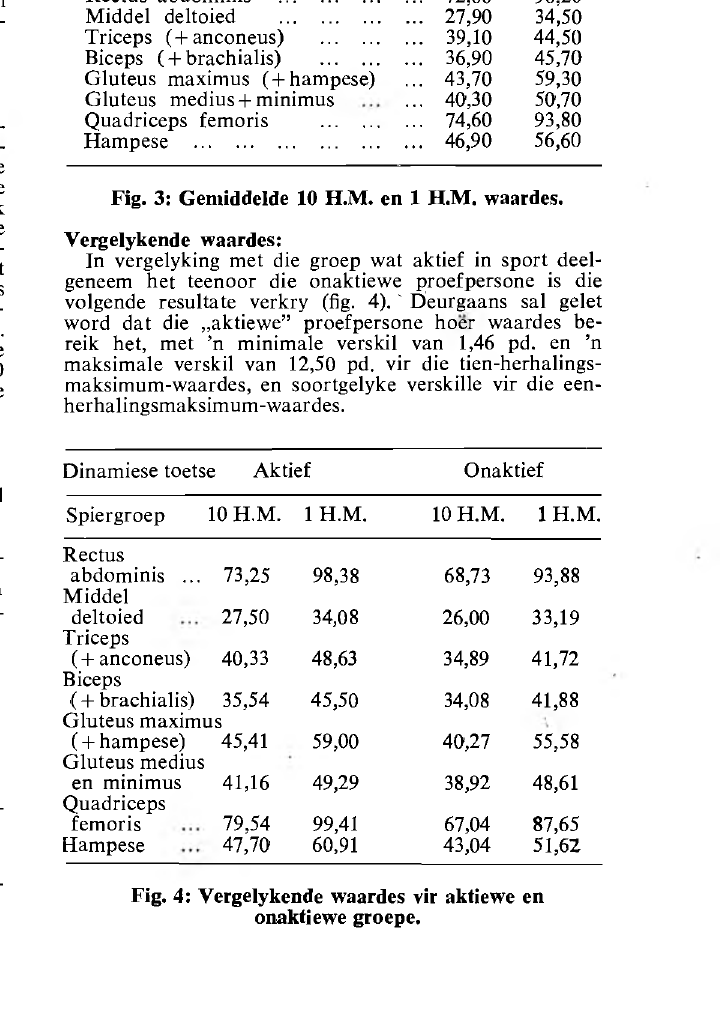
Fig. 2: m. Deltoideus (middel vesels) — 1 H.M. Na statistiese ontleding is die gemiddeldewaardes vir agt verskillende spiergroepe soos volg vasgestel (Fig. 3). Spiergroep